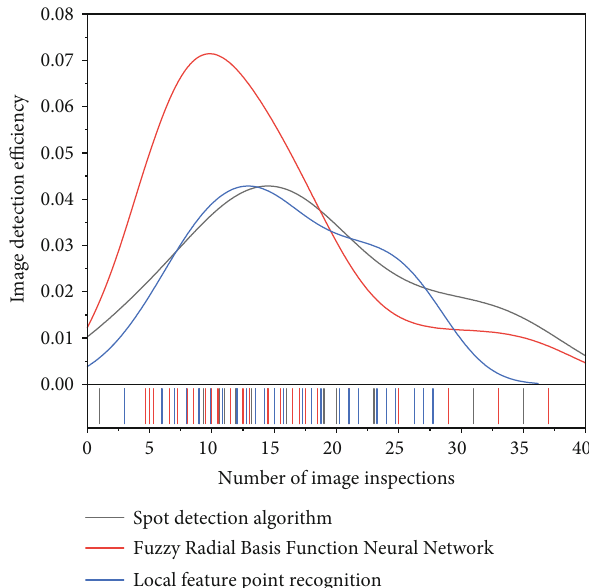
Figure 5: Image detection method improvement e ffi ciency change graph.